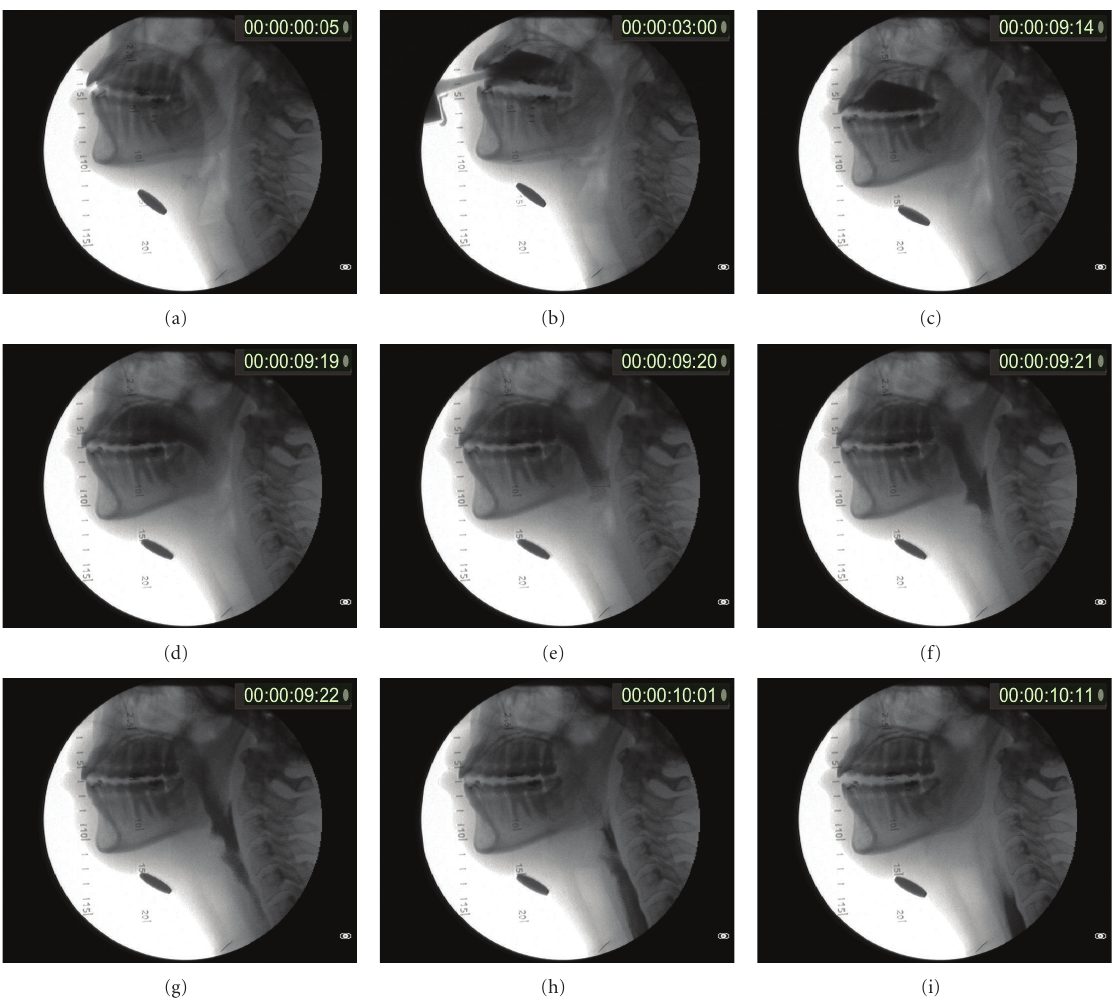
Figure 3: Normal swallowing. The sequence of the phases of deglutition is demonstrated in still pictures of a videofluoroscopic examination. (a) Normal anatomy at rest. (b) The contrast is introduced in the mouth with a syringe. (c) Oral phase, bolus preparation. (d) Bolus posterior propulsion. (e) The pharyngeal phase is triggered when the bolus enters the oropharynx. (f) Laryngeal closure. (g) Opening of the upper esophageal sphincter. (h) and (i) Esophageal phase. Note that it takes less than a second to complete the transit of the bolus through the